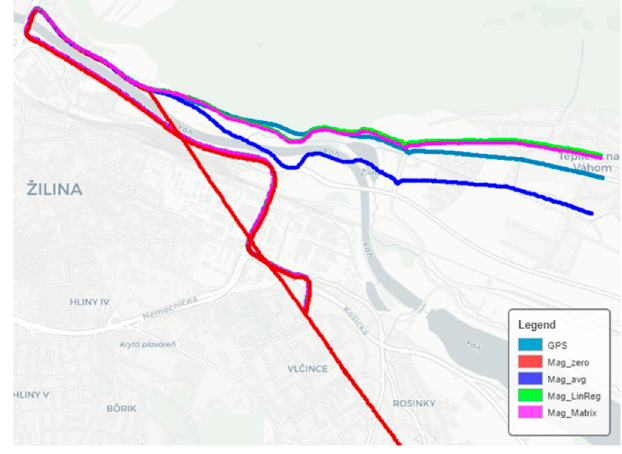
Figure 6. Map calibration and subsequent position prediction.